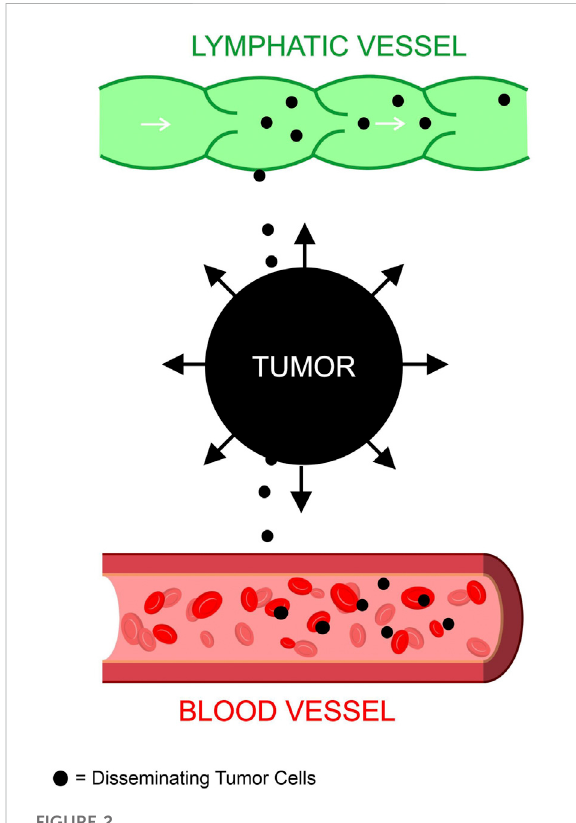
FIGURE 2 Tumor interstitial fl uid pressure contributes to